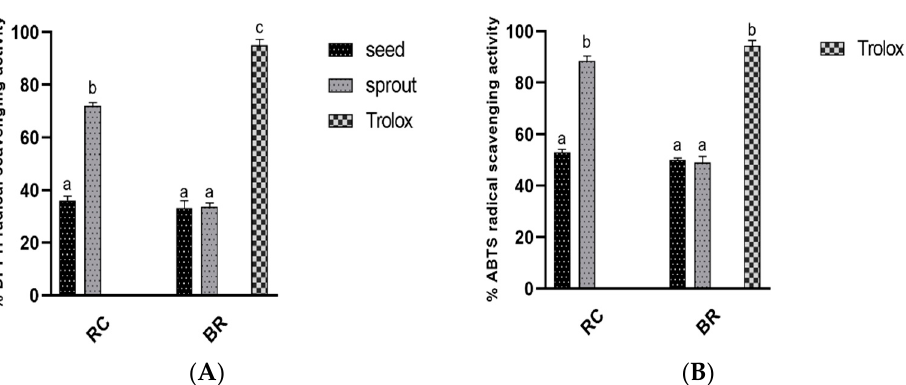
Figure 2. Antioxidant capacity levels of 1 mg/mL ethanol extracts of red cabbage and broccoli (seeds and sprouts): ( A ) percentage 2,2 (cid:48) -diphenyl-1-picrylhydrazyl (DPPH) radical scavenging activity values; ( B ) 2,2 (cid:48) -Azino-bis (3-ethylbenzothiazoline-6-sulfonate. BR, broccoli; RC, red